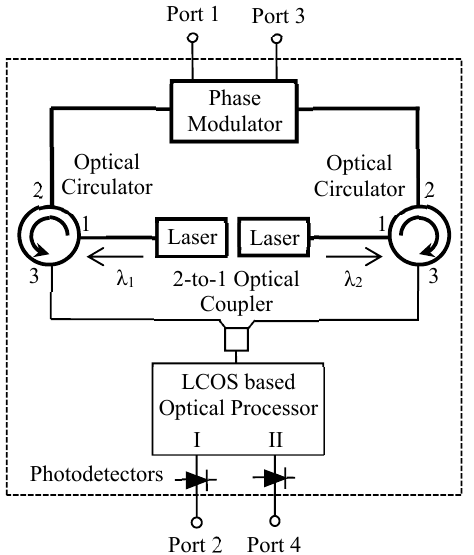
Figure 14. The structure of the photonics-based microwave hybrid coupler. The bold line represents the polarization maintaining components.